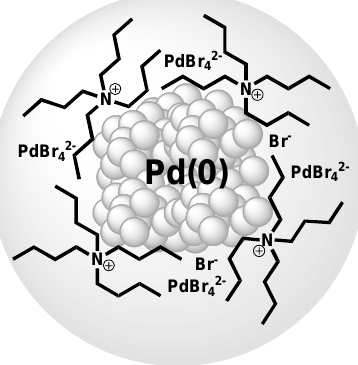
Figure 2. Model of Pd-NPs stabilised by layers of TBAB and [PdBr 42 − ]. Copyright from reference